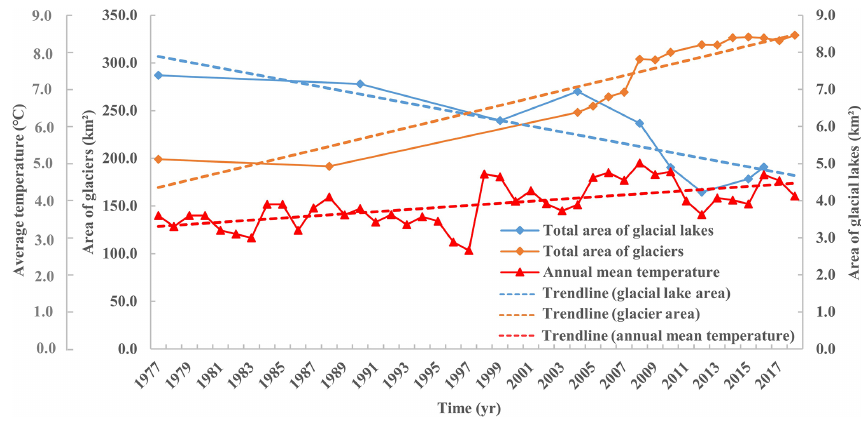
Figure 12. Changes in the area of the five typical glacial lakes and glaciers vs. temperature.